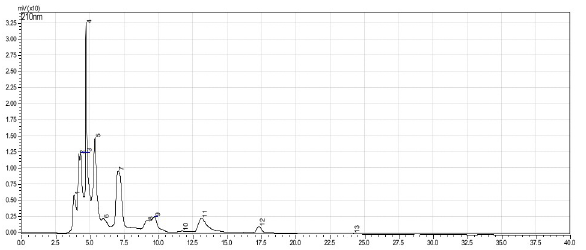
Fig 5. The HPLC fingerprint of aqueous extract of A . esculentus .